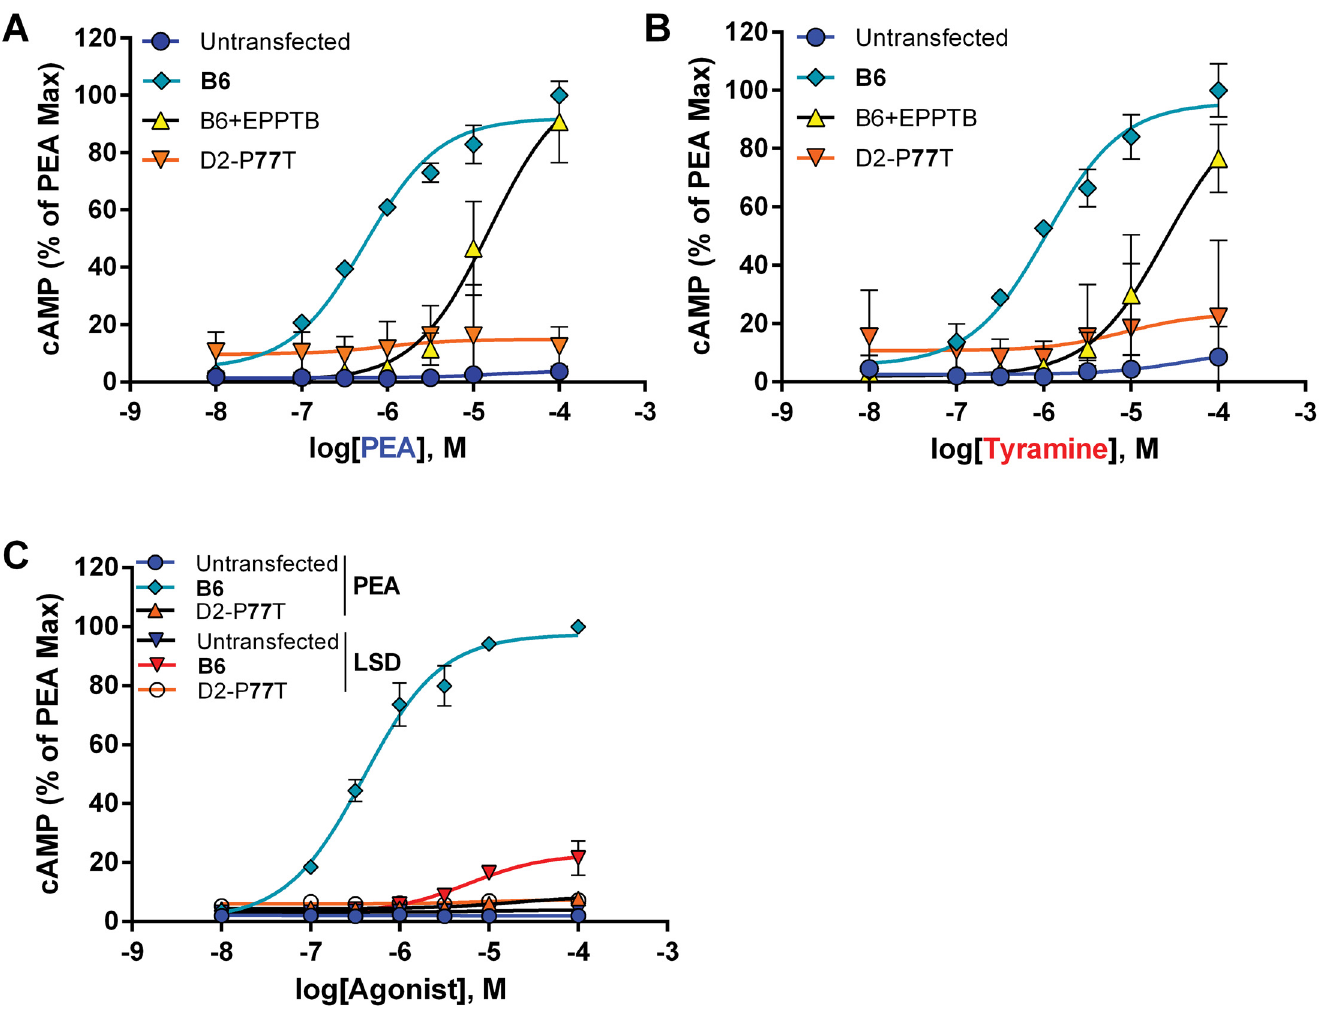
Fig 2. β -PEA and tyramine stimulate recombinant B6 but not D2 mTAAR1. The endogenous ligands, β -PEA (A) and tyramine (B) elicited a dose- dependent response in mammalian cells expressing recombinant B6-like, but not the D2-like (P77T) mTAAR1. Dose-response curves for the recombinant B6-like receptor were shifted to the right by EPPTB (10 μ M). β -PEA EC 50 = 0.547 ± 0.03 μ M; Tyramine EC 50 = 0.940 ± 0.12 μ M. LSD has no effect on either receptor (C).